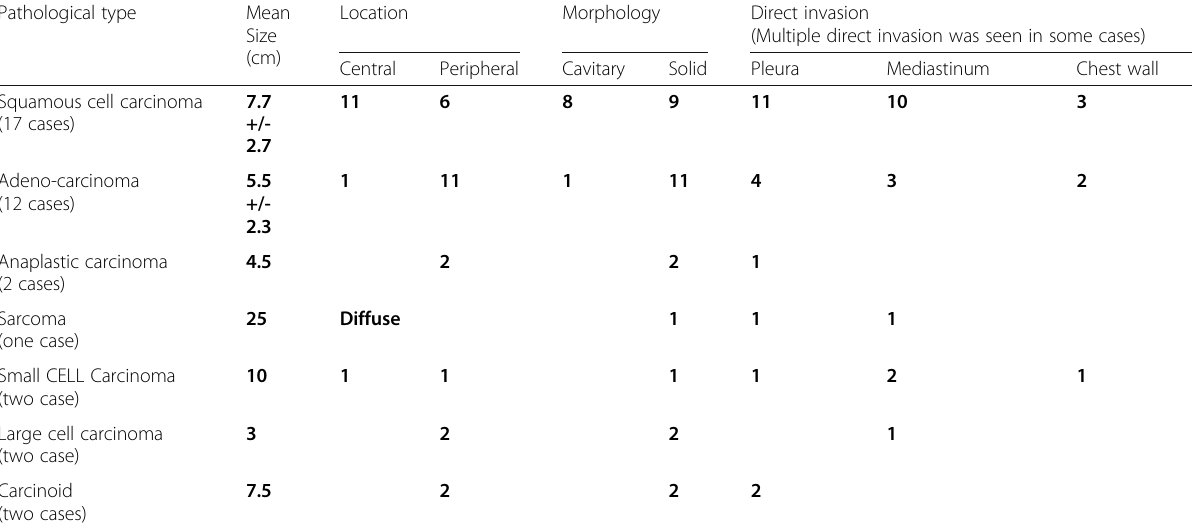
(Multiple direct invasion was seen in some cases)